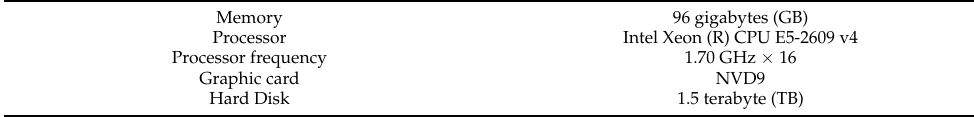
Table 4. Hardware characteristics. CPU: central processor